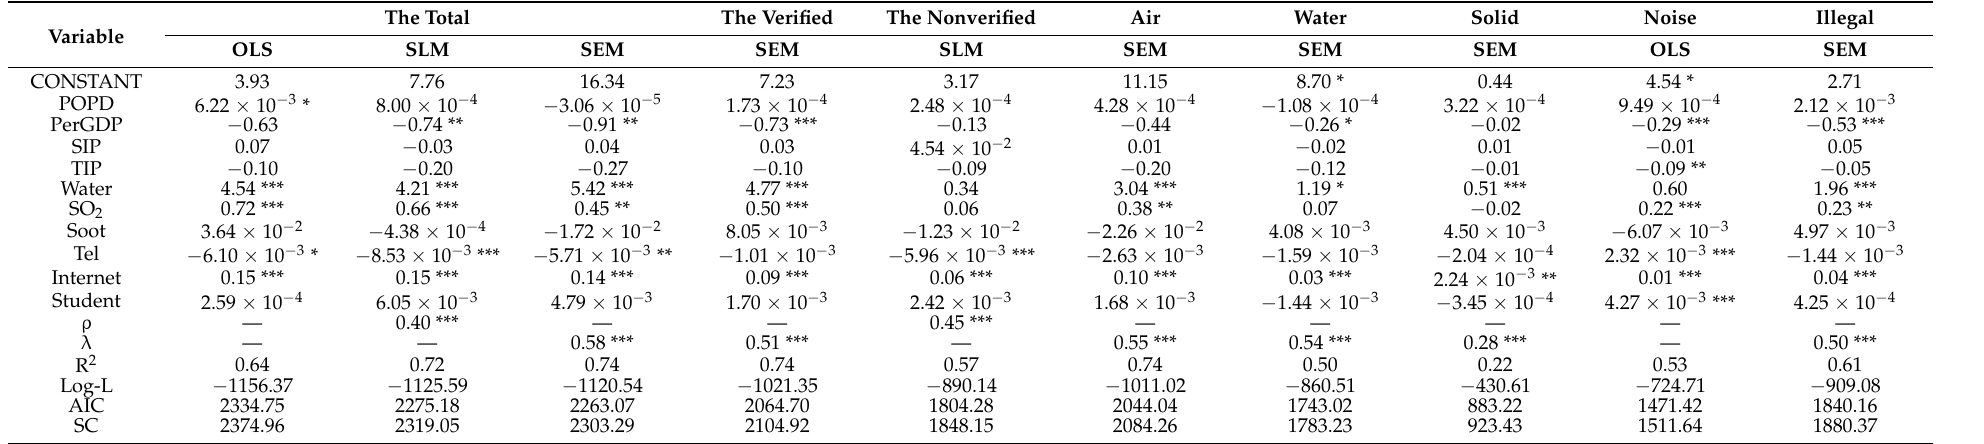
Table 4. Regression model